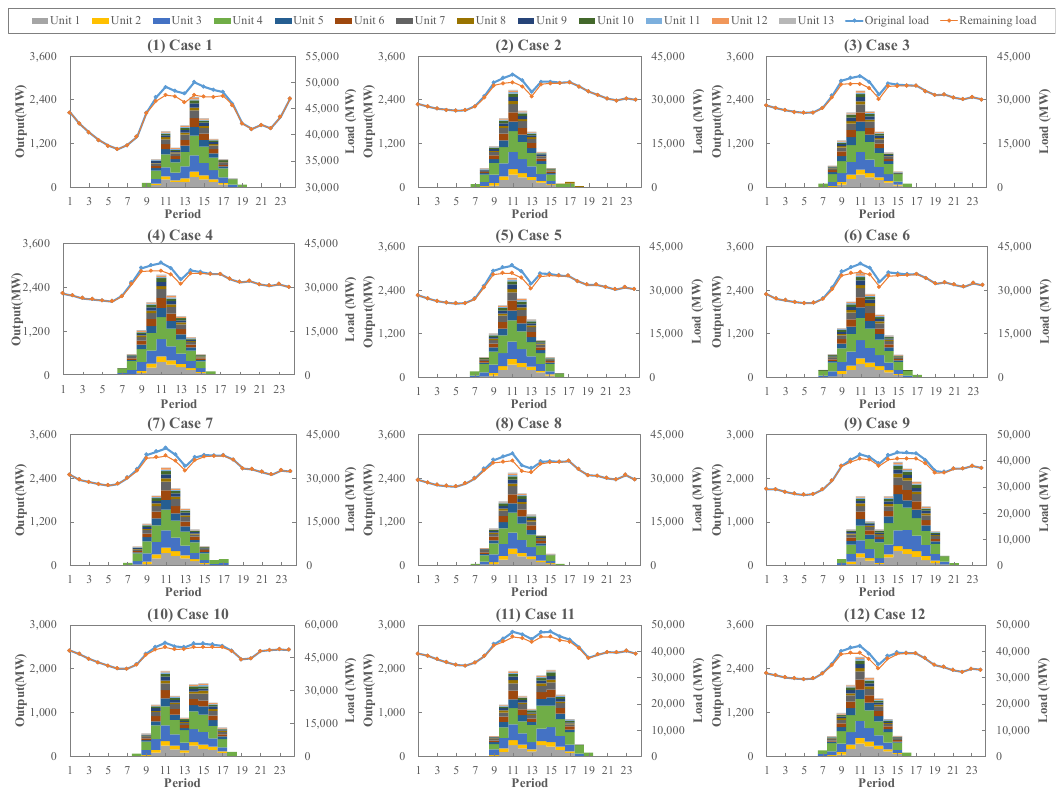
Figure 7. Scheduling results of the MILP model in Case 3.